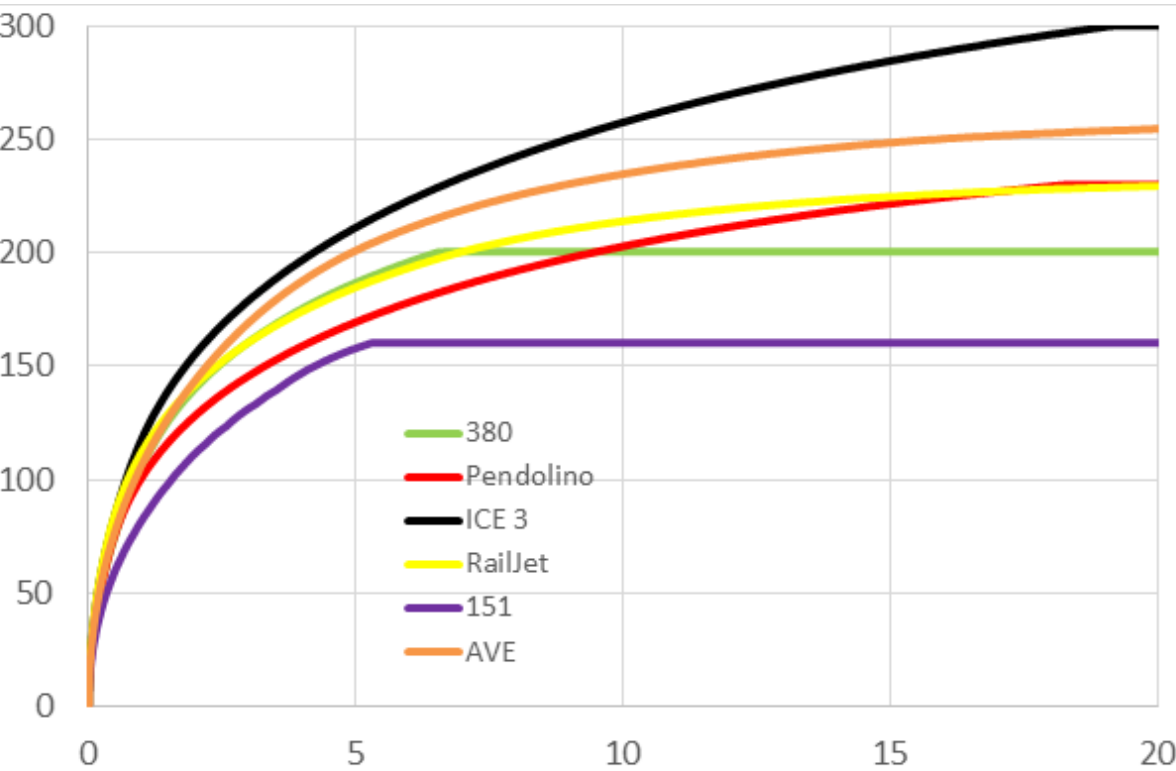
Figure 1. The distance needed for acceleration [km], source: